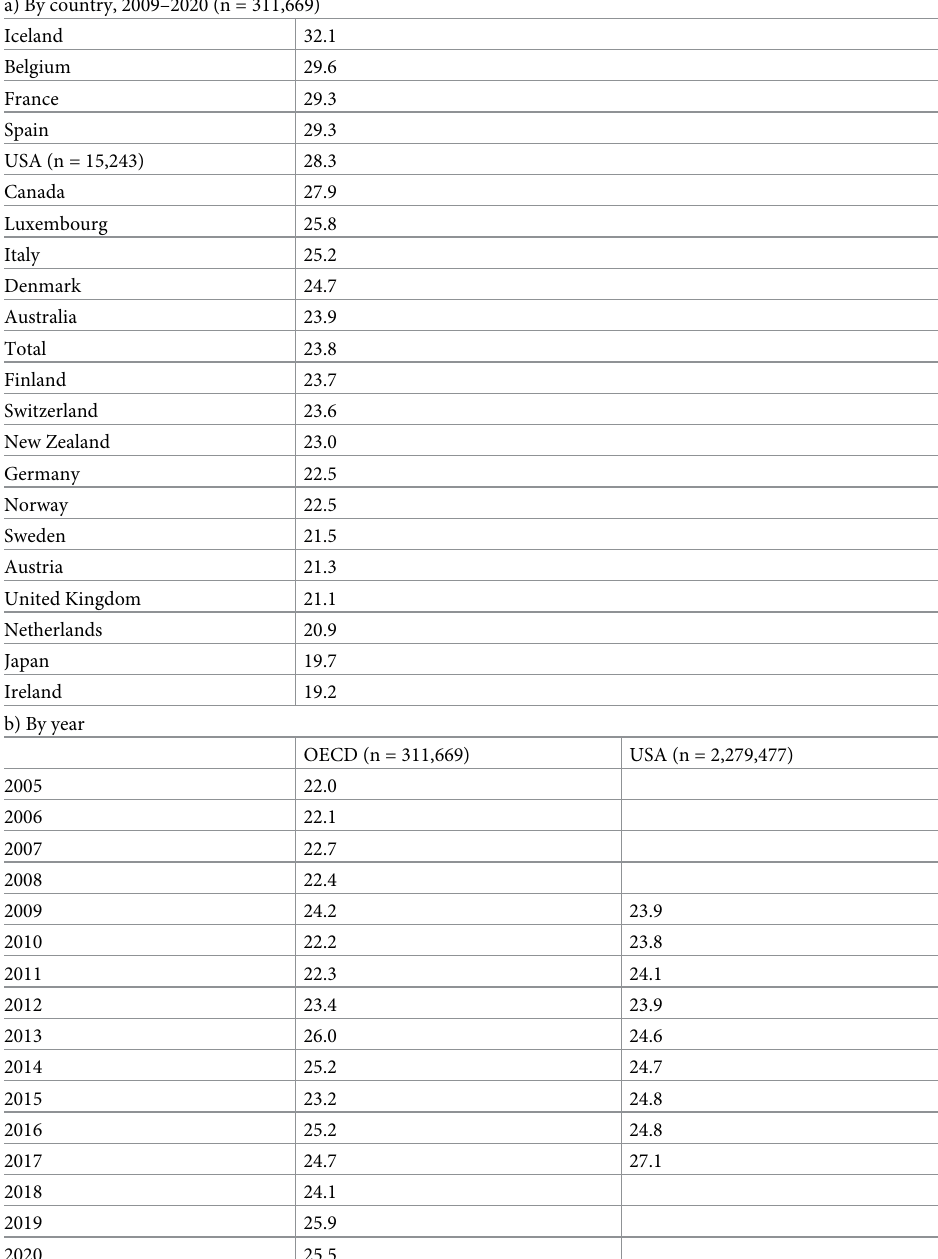
Table 1. Pain rates in the gallup world poll, 2009–2020 and gallup US tracker poll, 2009–2017. a) By country, 2009–2020 (n = 311,669)